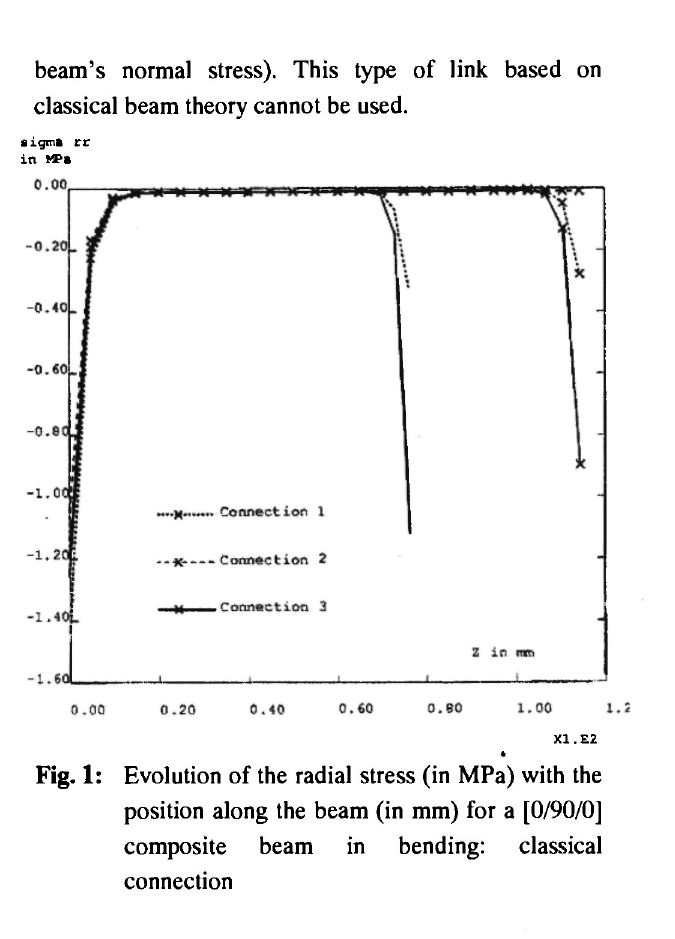
Fig. 1: Evolution of the radial stress (in MPa) with the position along the beam (in mm) for a [0/90/0] composite beam in bending: